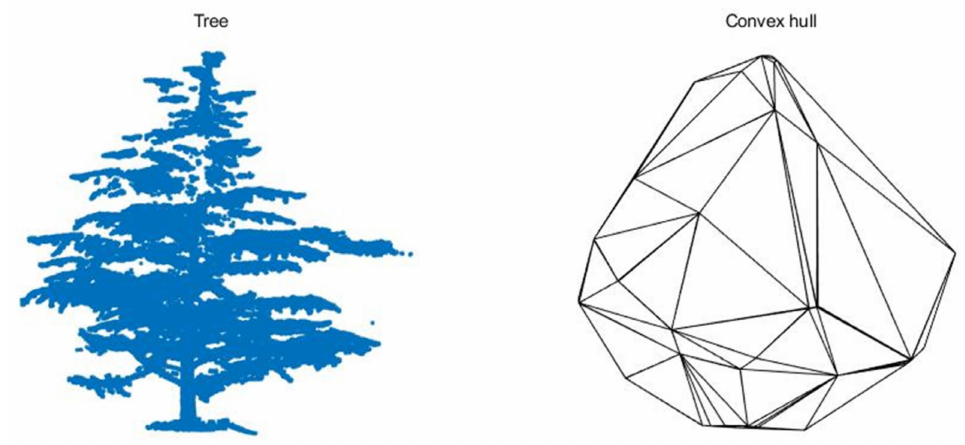
Figure 6. The diagram of the Convex hull